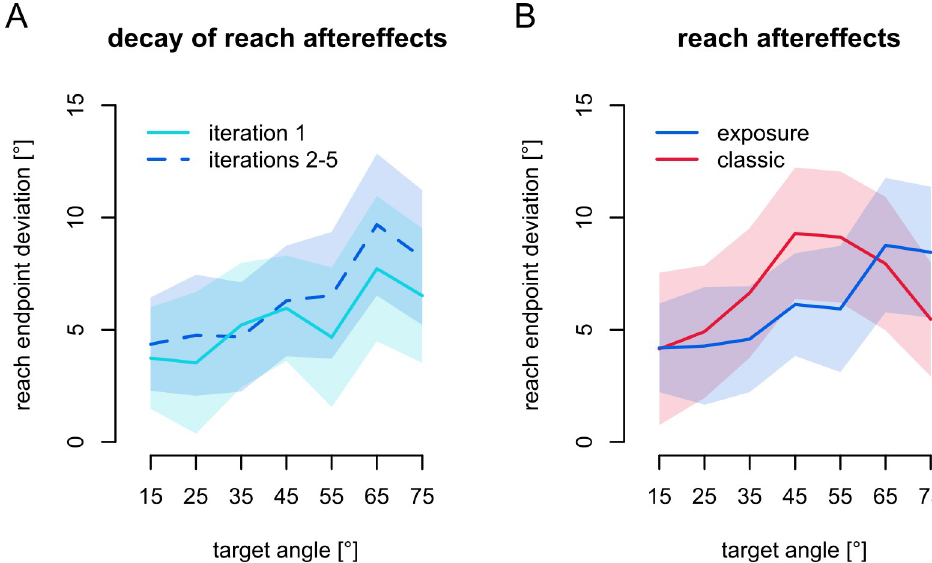
Fig 4. Reach aftereffects. Changes of the angle of reach endpoints in the no-cursor tasks after rotated training. Shaded areas denote 95% confidence intervals. a) Reach aftereffects at different time points in the rotated session. Light blue : first no-cursor task in the rotated session (immediately following training), Dark blue , dashed line: the other four repetitions of the task (with localization in between training and no-cursor tasks). b) Reach aftereffects after classic and exposure training. Blue : exposure training, Red : classic